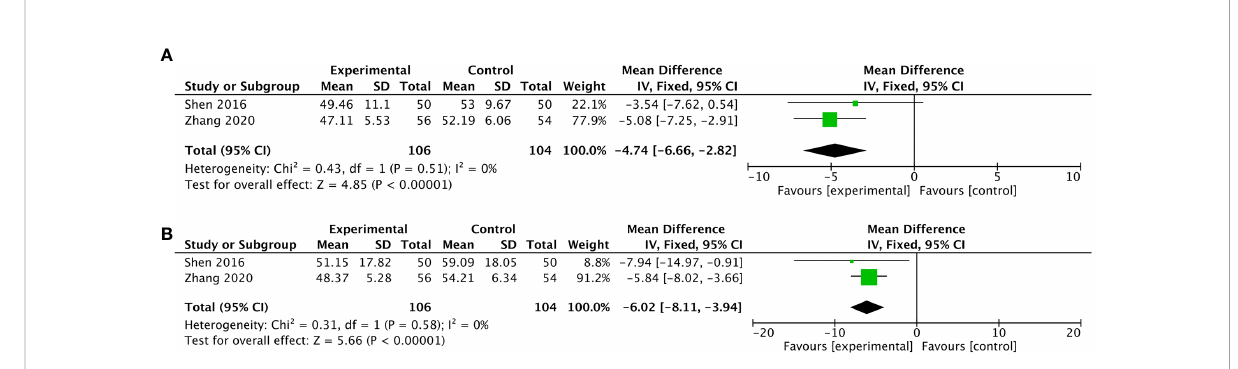
FIGURE 6 Forest plot of the fatigue in lung cancer patients treated with acupuncture and control. (A) the changes measured by the Self-Rating Anxiety Scale in lung cancer patients treated with acupuncture-related intervention versus control from the baseline to the end of treatment; (B) the changes measured by Self-Rating Depression Scale in lung cancer patients treated with acupuncture-related intervention versus control from the baseline to the end of treatment. IV, inverse variance; CI, con fi dence